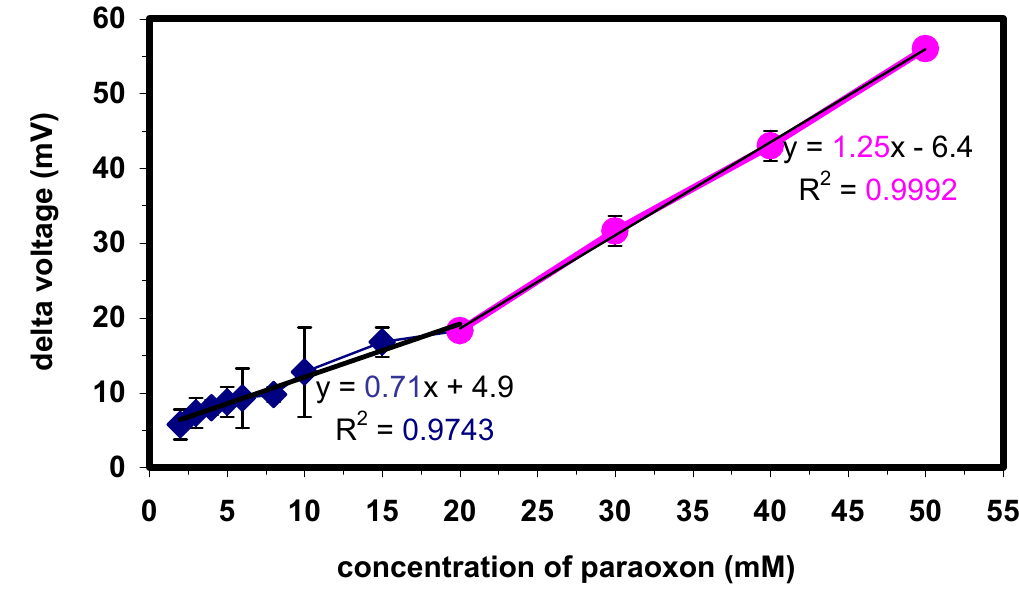
O as pH transducer. The 2 5